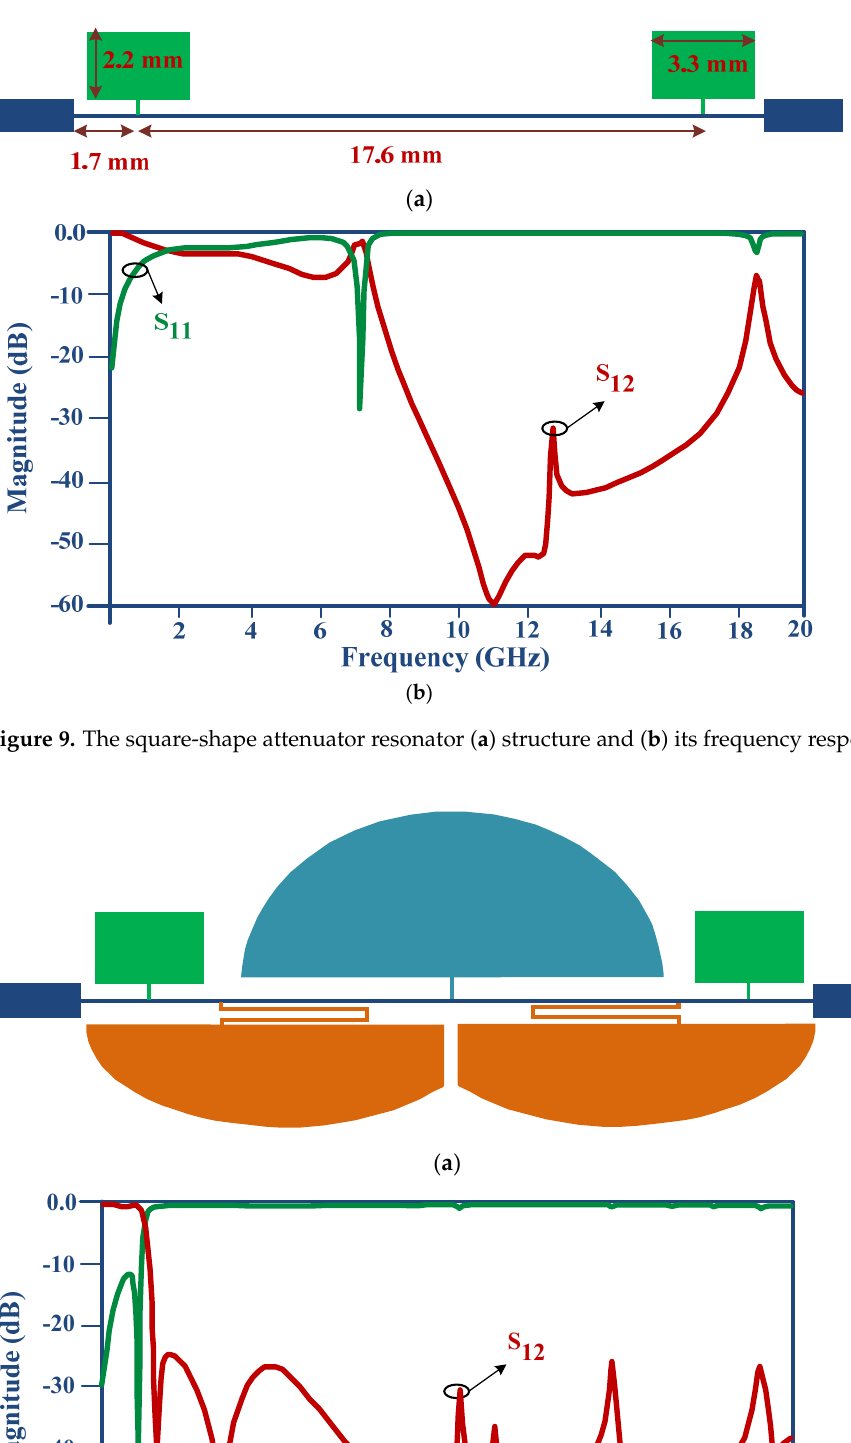
Figure 10. The attenuator resonator ( a ) structure and ( b ) its frequency response.